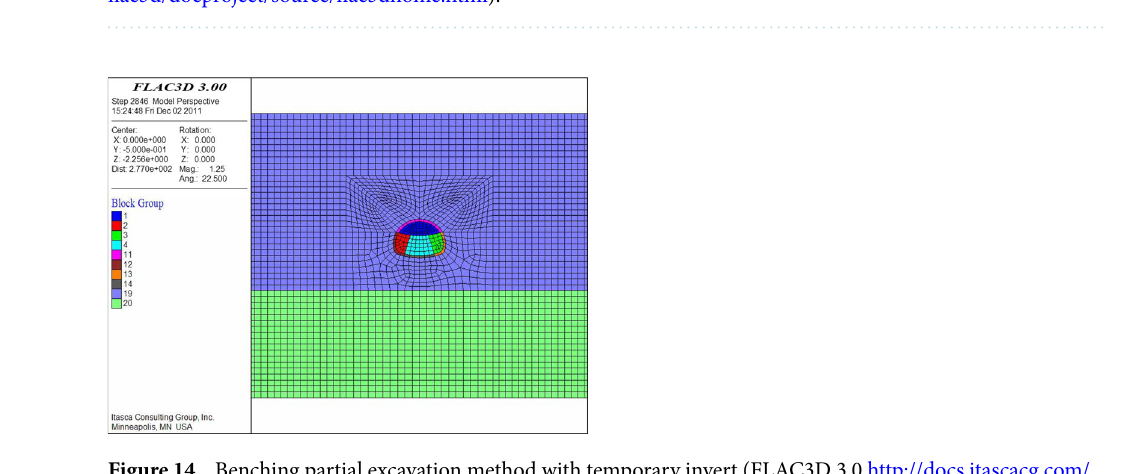
Figure 13. Three-bench method with temporary invert (FLAC3D 3.0 http:// docs. itasc acg. com/ flac3 d700/ flac3d/ docpr oject/ source/ flac3 dhome. html).